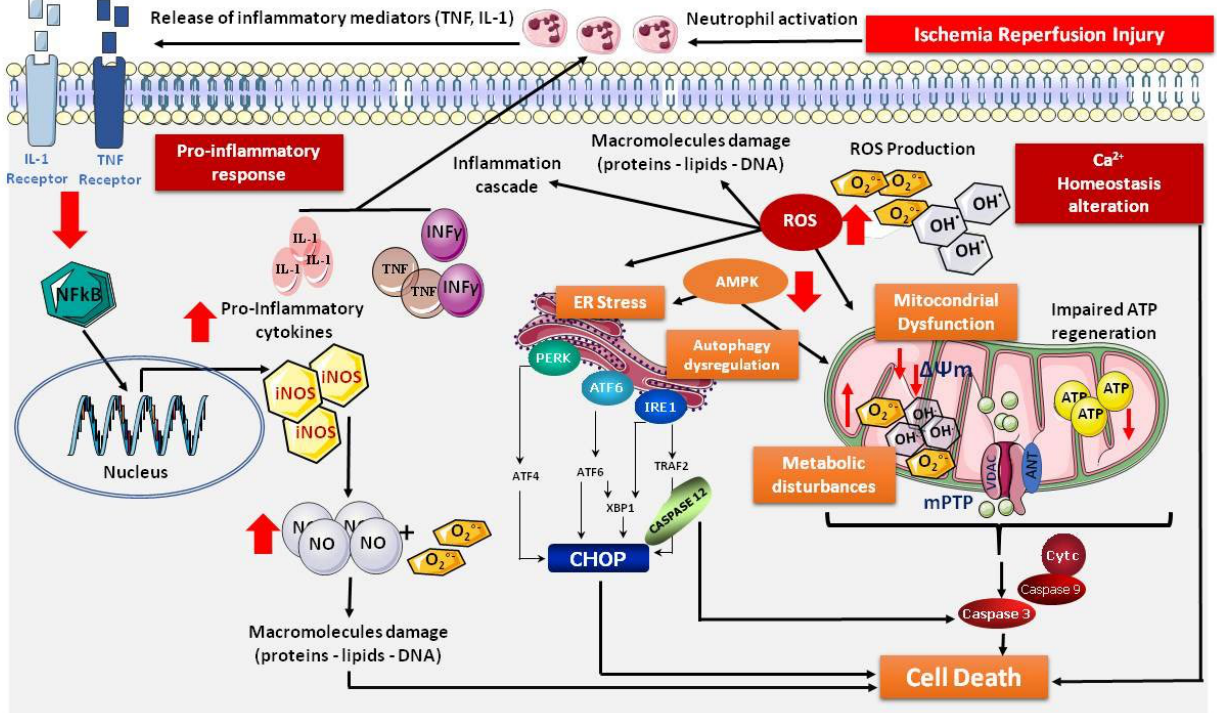
Figure 1. Schematic representation of the signaling pathways affected by IRI during organ preser-